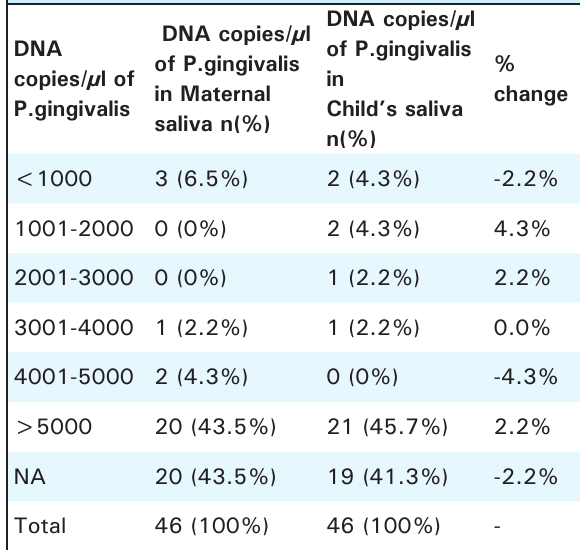
Table 3. Real time PCR result for DNA copies